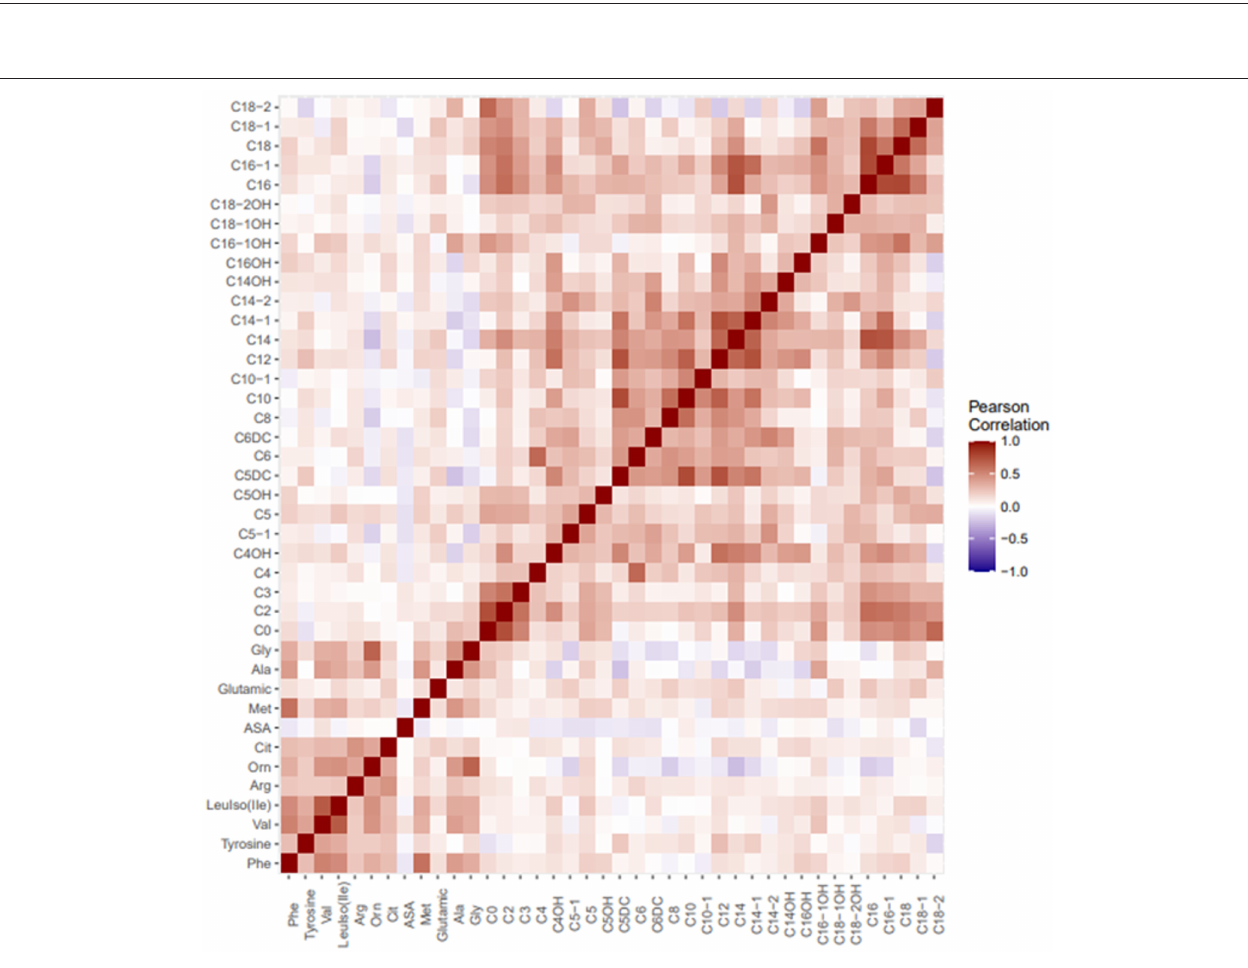
FIGURE 4 | Heatmap visualizing correlations between metabolites in tandem MS/MS amino acid and carnitine profile.